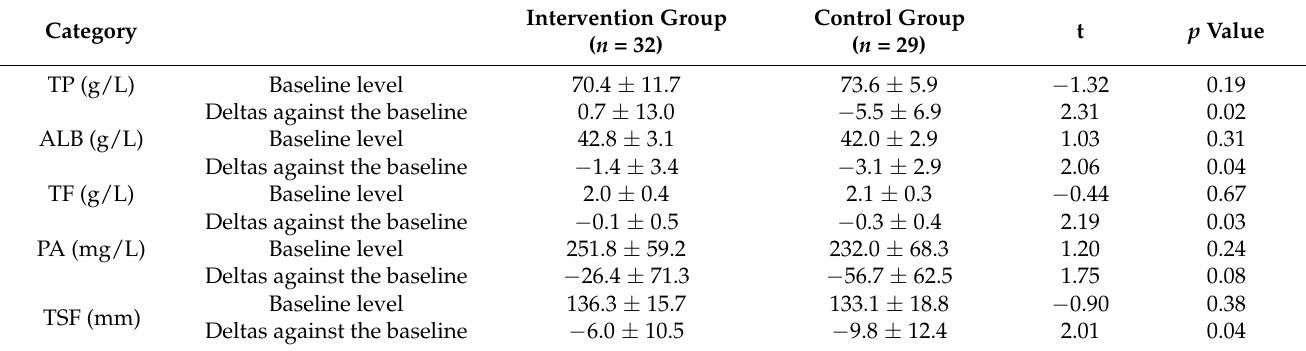
Table 6. Comparison of nutritional indexes between the two groups (Mean ±